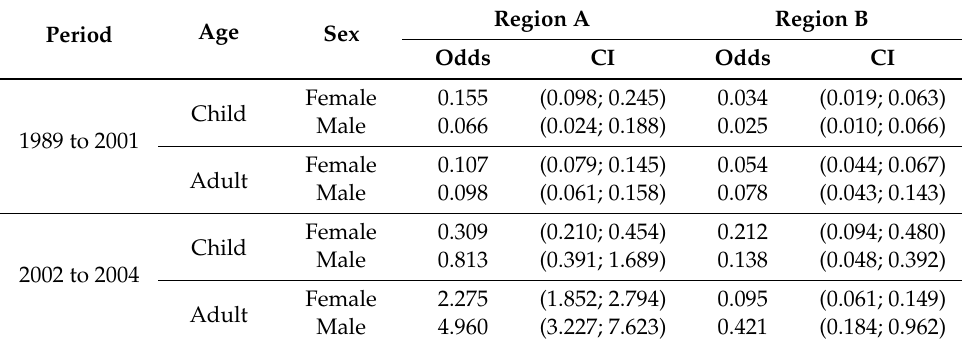
Table 2. Odds of primary hypothyroidism (PH) and 95% confidence intervals (CI) for the pre-public disclosure period (1989 to 2001) and odds of PH and 95% confidence intervals (CI) for the post-public disclosure period (2002 to 2004).